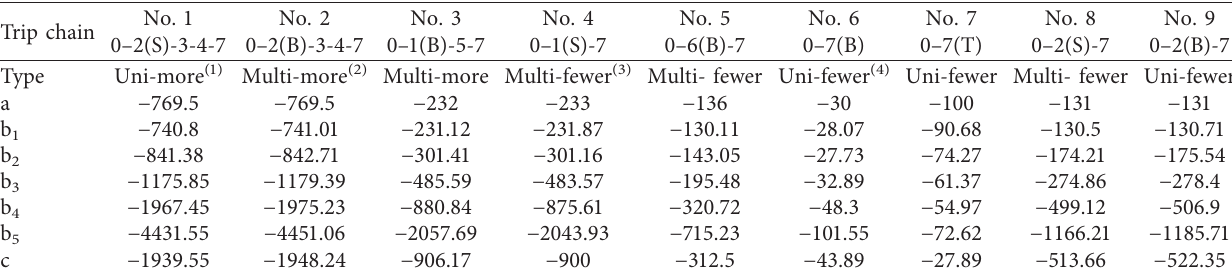
Table 8: Total of the action value in 9 trip chains of different